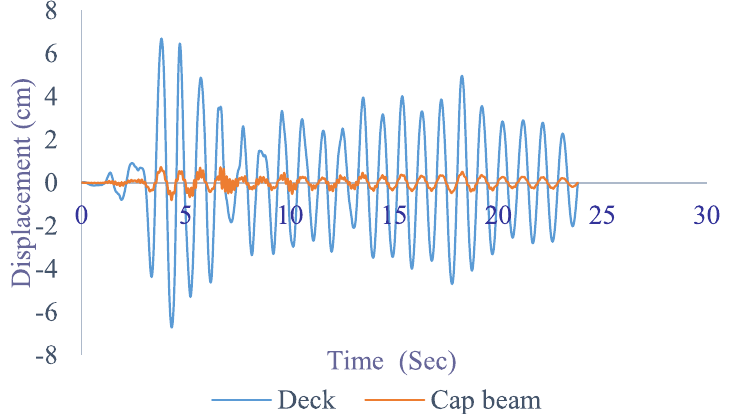
Fig. 15 The lateral displacement of points Deck and Cap beam in the longitudinal direction (X) in model 2 under the Tabas